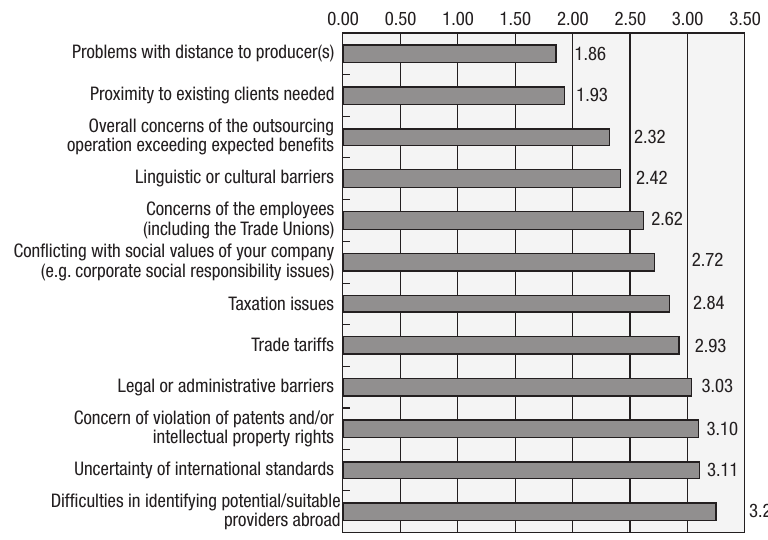
Fig. 2. Impediments to international